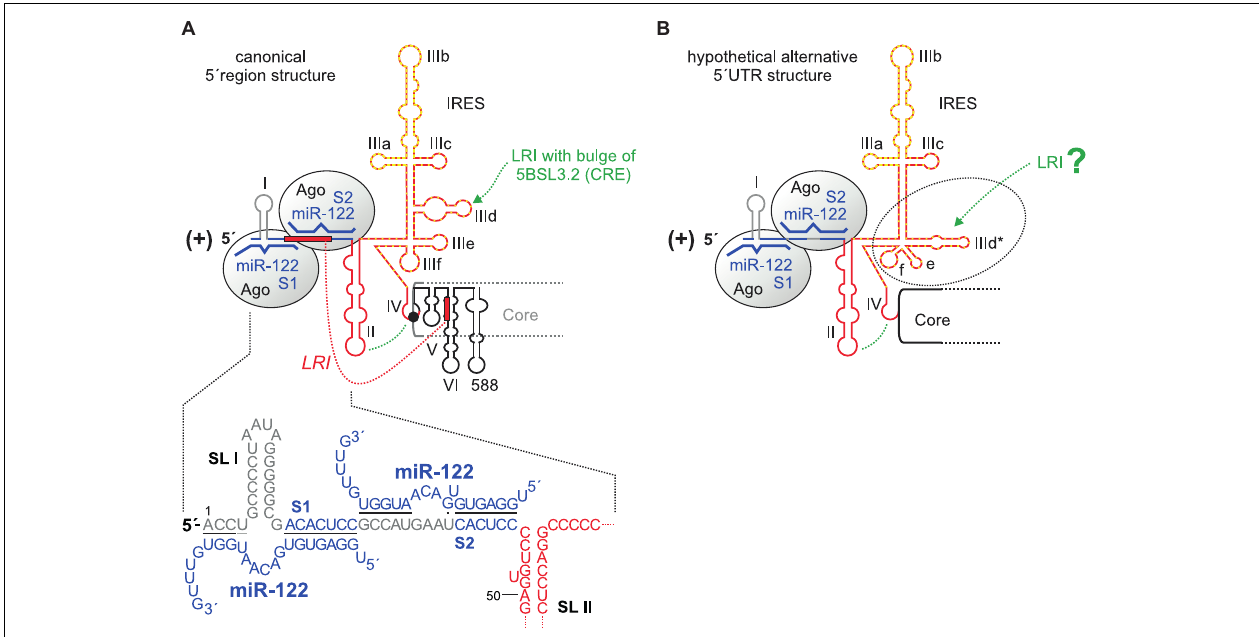
FIGURE 2 | The HCV 5 (cid:48) region. (A) The canonical HCV 5 (cid:48) UTR structure with the miR-122 binding sites S1 and S2, bound by Argonaute (Ago) protein. The region of the IRES that binds the small ribosomal 40S subunit in the SL III domain with the important SL IIId is shown by a red broken line, the eIF3 binding site with the important SL IIIb with a yellow dotted line. The SL II interacts with the SL IV to place the AUG into the mRNA entry channel of the 40S ribosomal subunit. SLs V, VI and 588 are located in the core protein coding region. The seed region of miR-122 (nucleotides 2–7 or 2–8) binds to the target sequence (A)CACUCC, and the miR-122 supplementary region binds to a variable number of target nucleotides. (B) A hypothetical alternative structure of the IRES in which the SL IIId region is largely rearranged (Fricke et al., 2015). This predicted structure is conserved among HCV isolates and is as thermodynamically stable as the canonical structure.